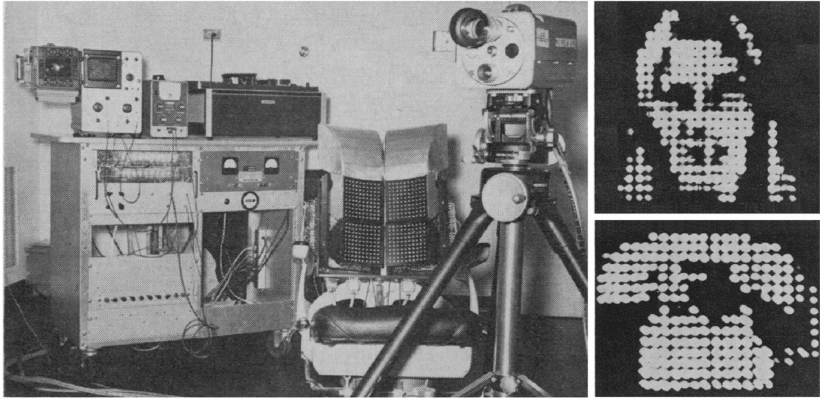
Figure 1. The “Tactile Television” by Paul Bach-y-Rita et